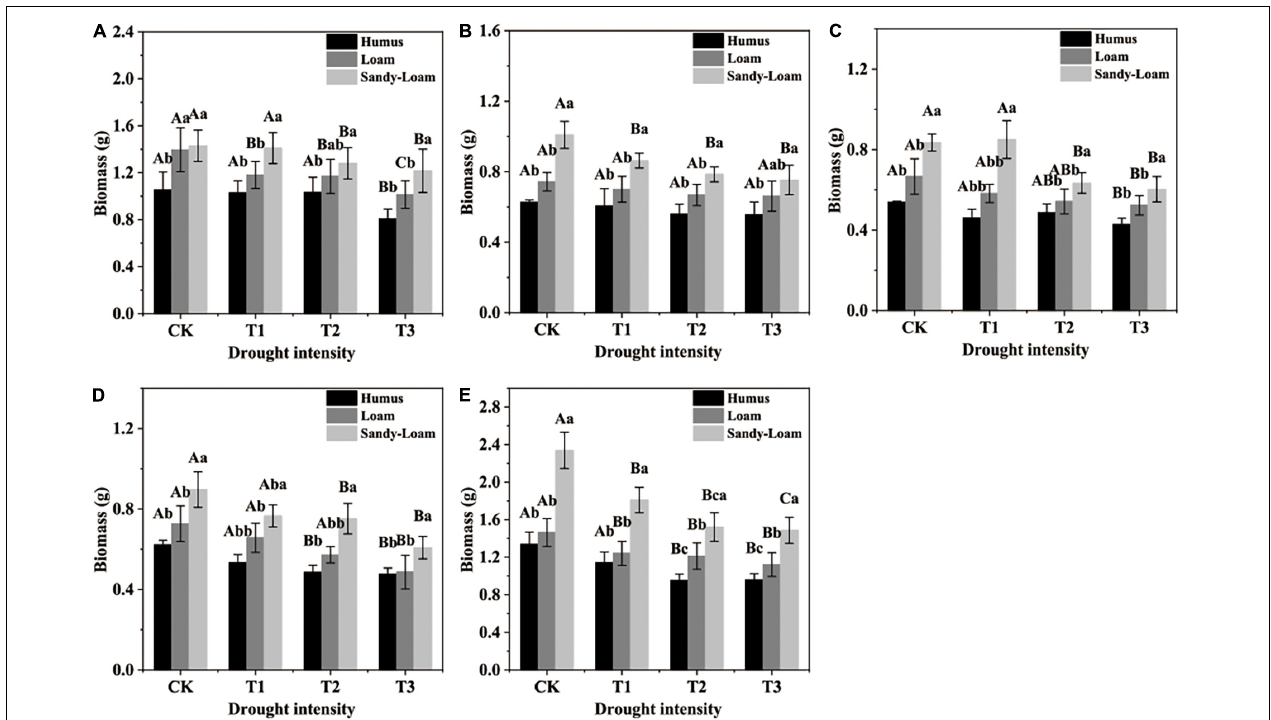
FIGURE 1 | The fine root biomass of Fraxinus mandshurica seedlings in different drought intensities and soil substrates. The different lowercase letters denote significant differences among soil substrates ( p < 0.05). The different uppercase letters denote significant differences among drought intensities ( p < 0.05). (A) 1st-order root; (B) 2nd-order root; (C) 3rd-order root; (D) 4th-order root; (E) 5th-order root. CK: control; T1: mild drought; T2: moderate drought; T3: severe